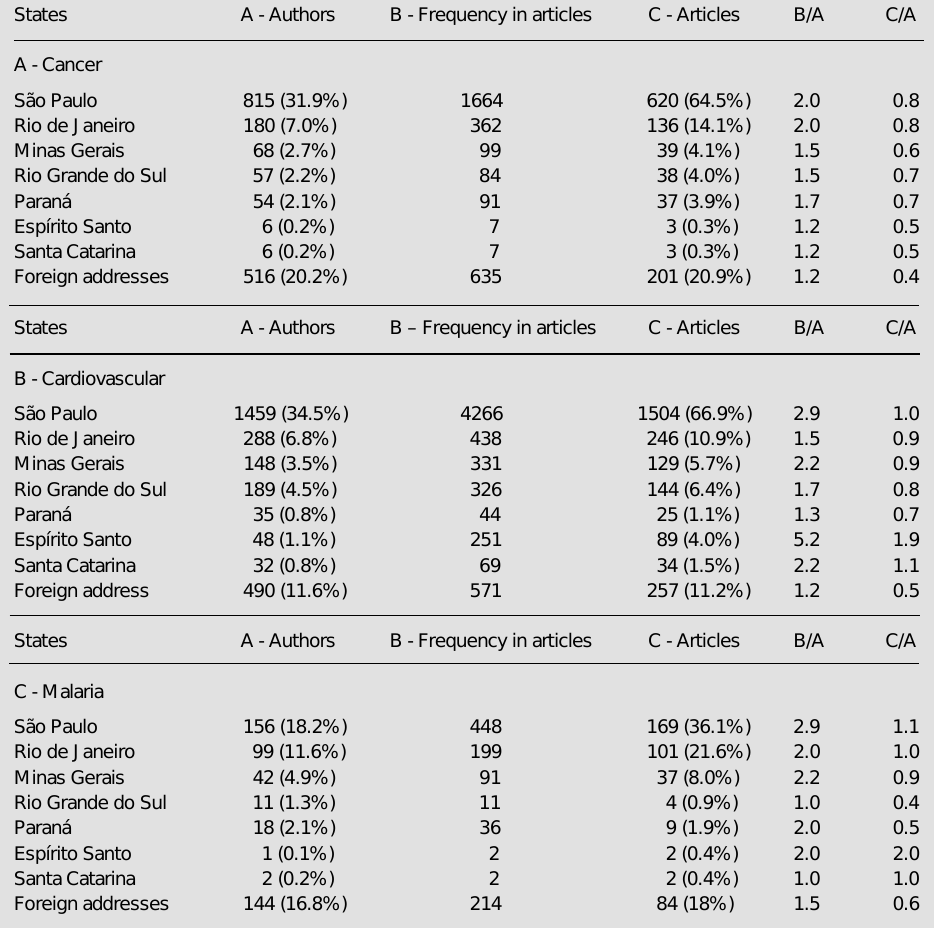
Table 6 - Geographical distribution of science output (81-95) in the Southeast and Southern regions of Brazil. States: Southeast and South states. A: Number of authors with the indicated state address; in parentheses - proportion of identified state addresses, as related to total number of authors; B: numbers indicating the frequency at which the respective state address and each author appear in the collected articles; C: number of articles presenting the indicated state address (the same article can be assigned to more than one state; in parentheses - proportions of total number of articles); D: total number of citations received by articles in C from 1981 to 1995. Foreign addresses: Authors and articles associated with foreign